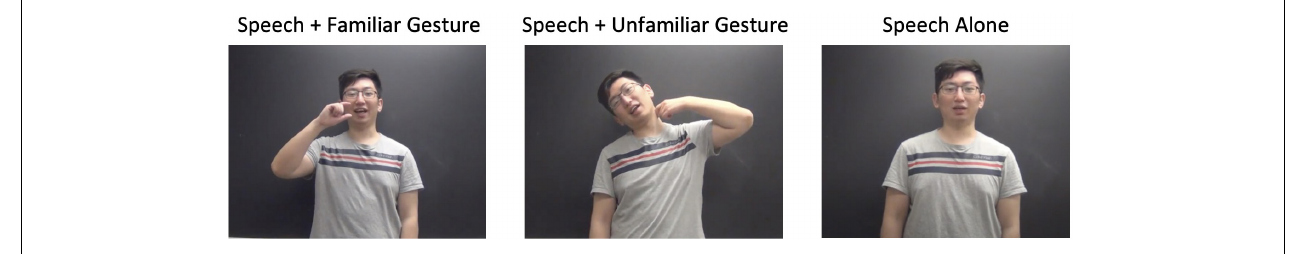
FIGURE 3 | Stimuli example from Experiment 2: Go for a drink? (“Nomi ni